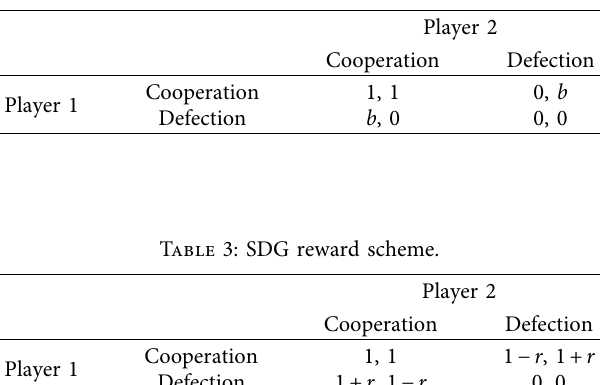
Table 2: PDG reward scheme.